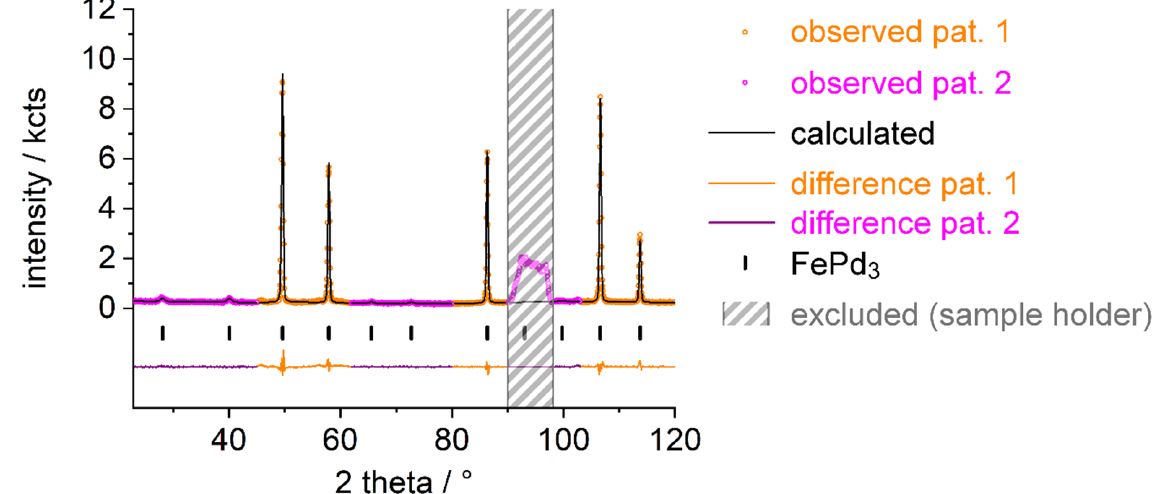
Figure A19. Rietveld refinement of the crystal structure of FePd 3 D 0.062(10) (for details, see seventh row in Tables A8 and A9) based on neutron powder diffraction data (NUMOR 131776 [21], λ =186.80(2) pm, D20 ILL, Grenoble) in a single-crystal sapphire cell at 447(3) K and 8.18(1 ) MPa deuterium pressure using FullProf [24].